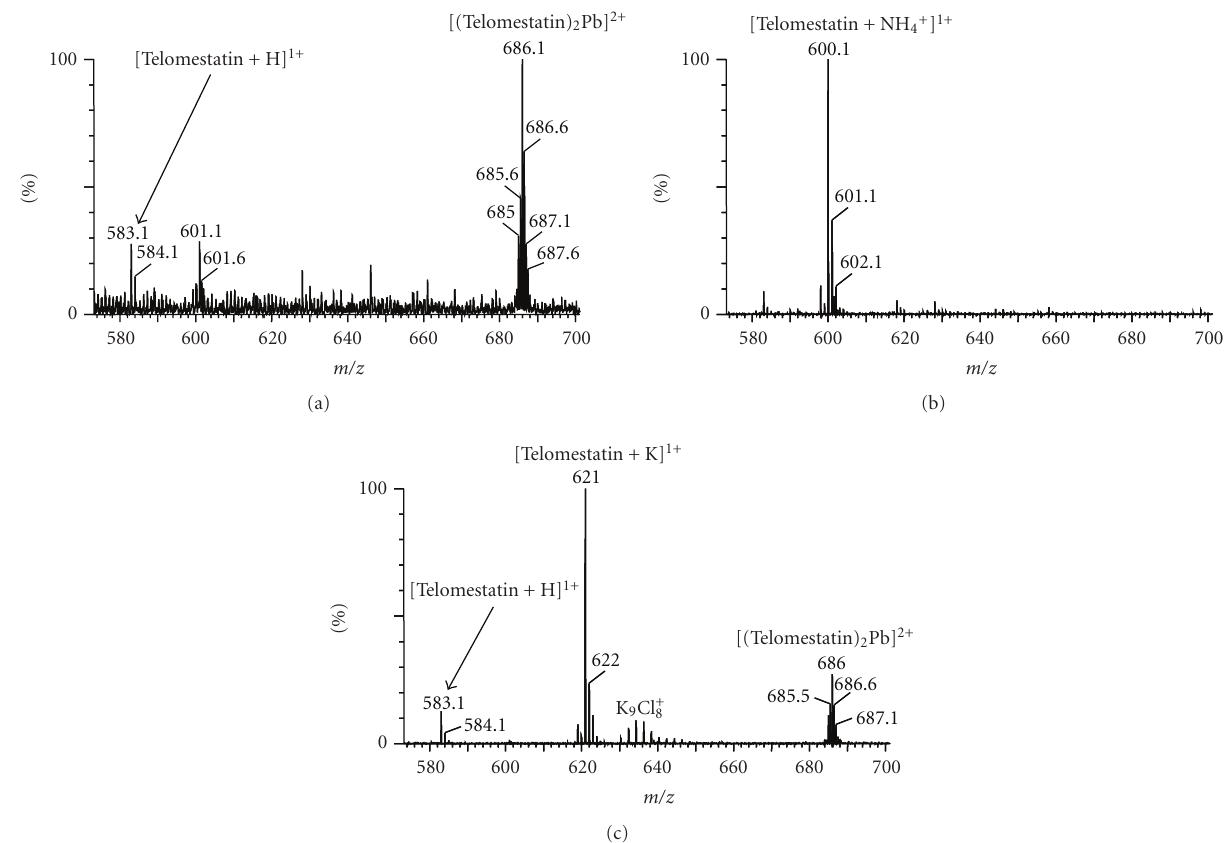
Figure 3: Positive ion mode electrospray mass spectra of 15 μ M telomestatin (a) in 80/20 water/methanol, (b) in 80/20 water methanol and 5 μ M ammonium acetate, and (c) in 80/20 water methanol and 5 μ M potassium